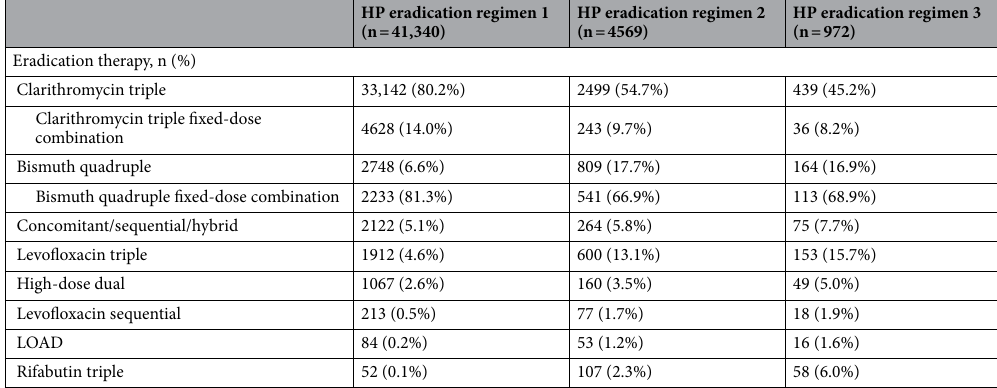
Table 2. Helicobacter pylori (HP) eradication regimens. LOAD, levofloxacin, omeprazole, Alinia [nitazoxanide], and